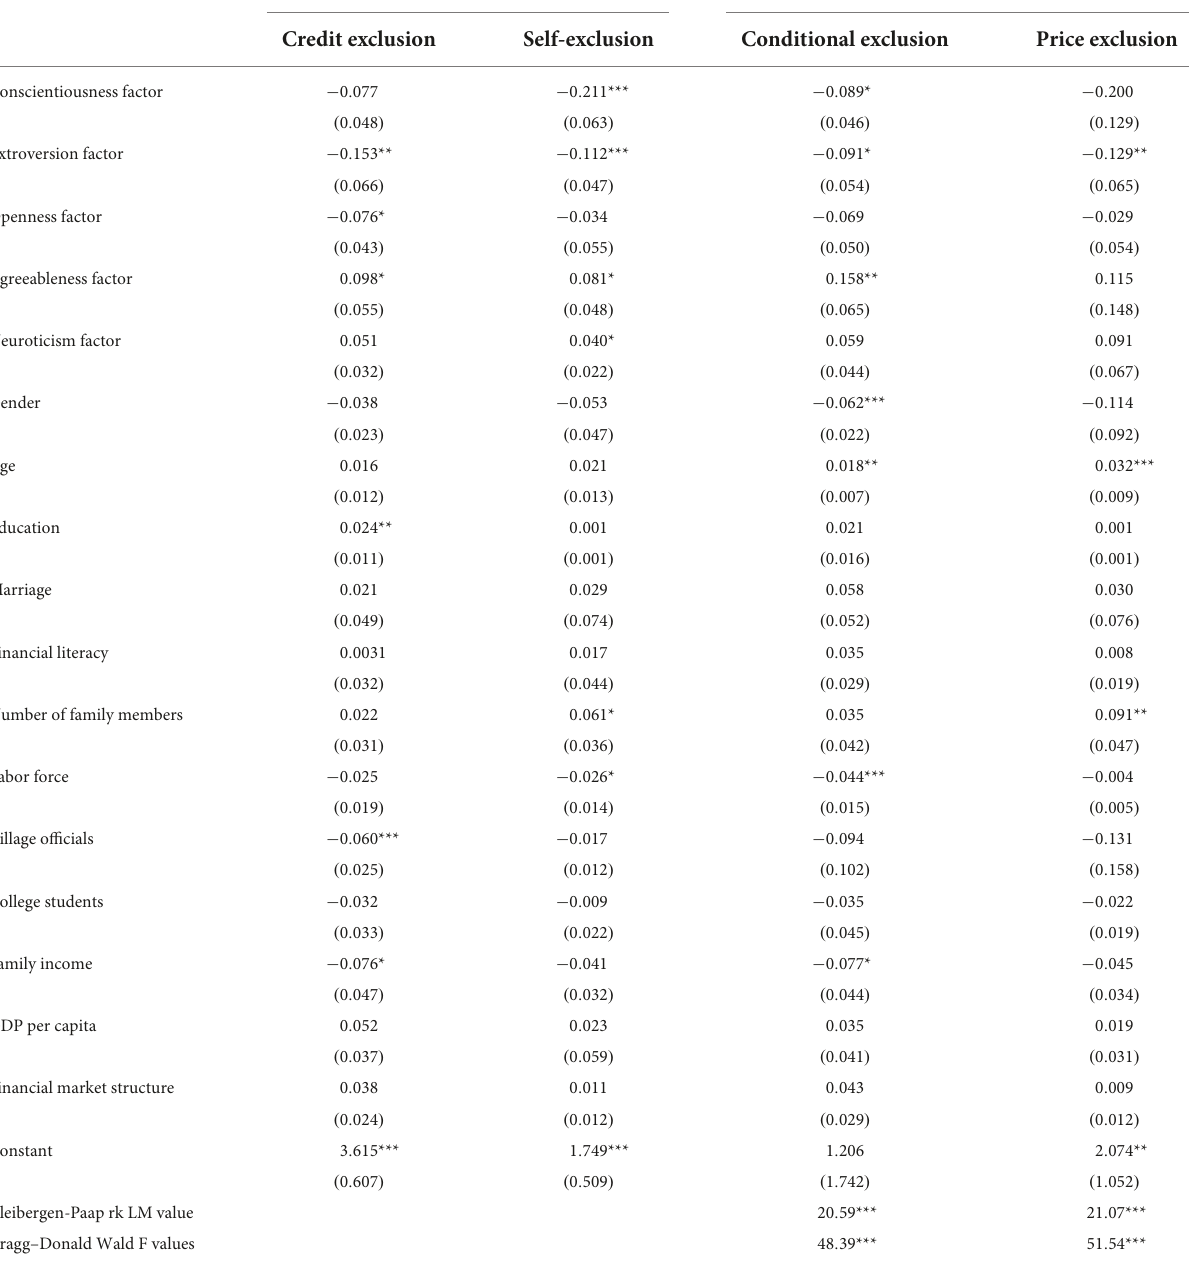
TABLE 8 Robustness and endogeneity test regression